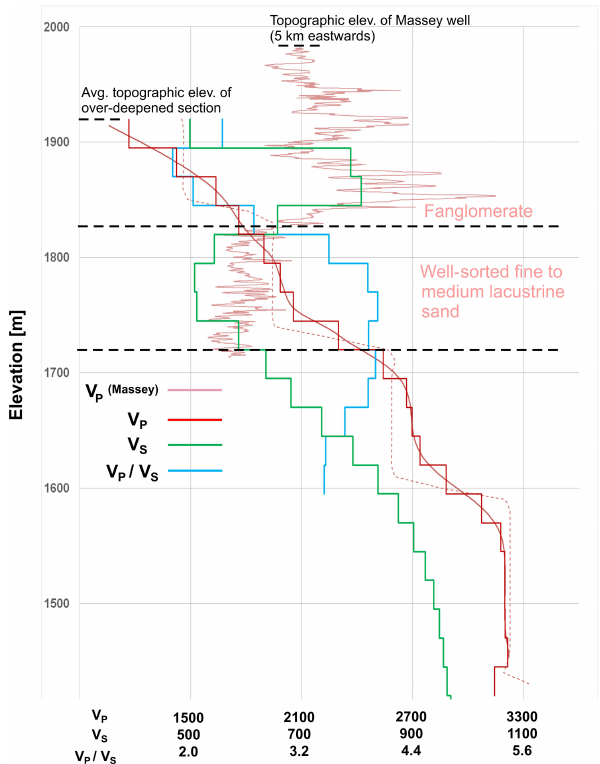
Figure 11. Compilation of several 1-D velocity models representa- tive of the over-deepened section. Dashed red line: interval P-wave velocity model from reflection processing (Patterson et al., 2018b). Smooth solid red line: P-wave velocity model from the combination of interval and tomographic velocities. Solid red staircase line: aver- aged P-wave velocities used for V P /V S calculation. Green staircase line: shear wave velocities from dispersion inversion. Blue staircase line: V P /V S ratio of the upper section. The lithologic interpretation and sonic log (bright red line) are from the Massey well located at 5km of distance to the seismic